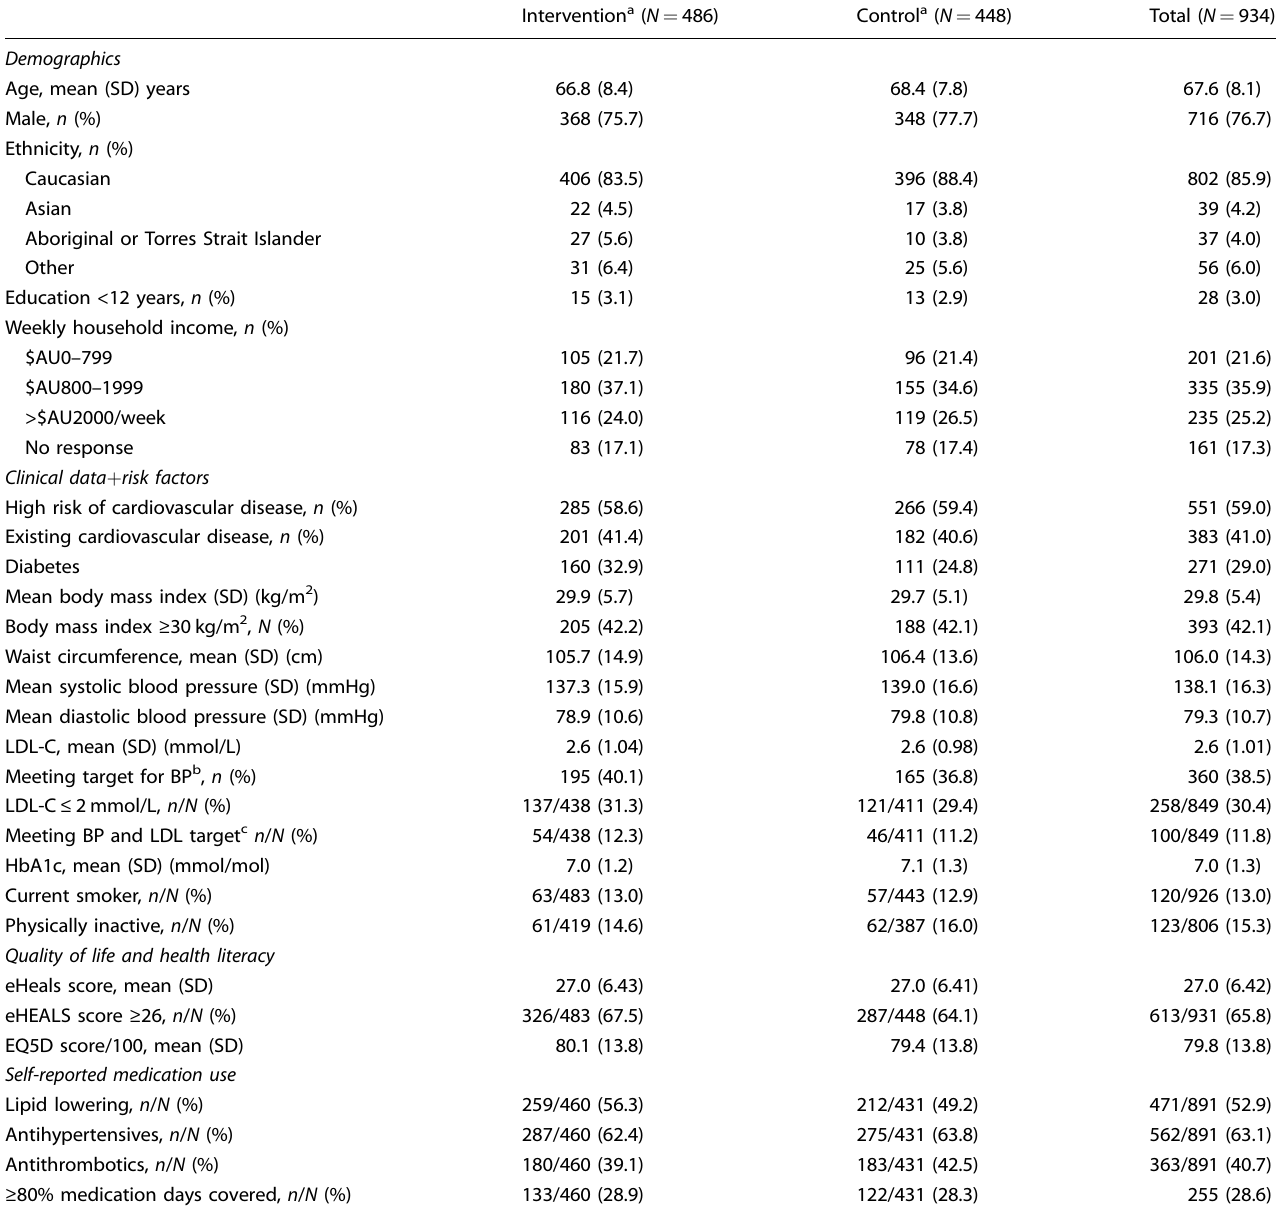
Table 1. Baseline